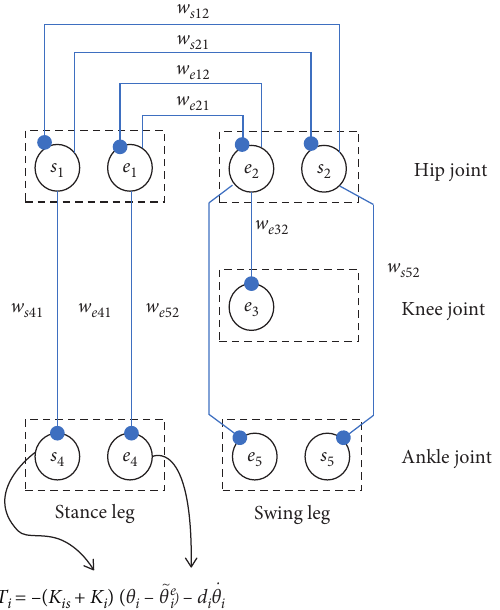
Figure 3: Each coupled oscillator sends joint torque and joint stiffness commands. w e ij and w s ij represent the weights of inter- connections between the